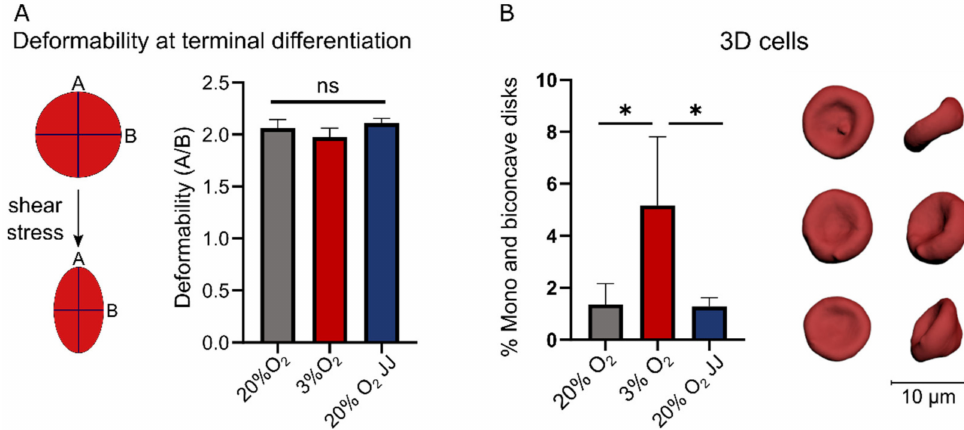
Figure 4. Deformability and 3D morphology of formed reticulocytes at terminal differentiation. ( A ) A functional assay measuring the deformability of reticulocytes revealed no differences between all culture conditions. ( B ) 3D confocal imaging highlighted on average three times more reticulocytes with a concave or biconcave shape in 3% O 2 cultures. Front and side views of three representative reticulocytes from one volunteer are given. ns = non-significant, * = p < 0.05. 3.5. Metabolic Activity during In Vitro Erythropoiesis Is Changed between 3% and